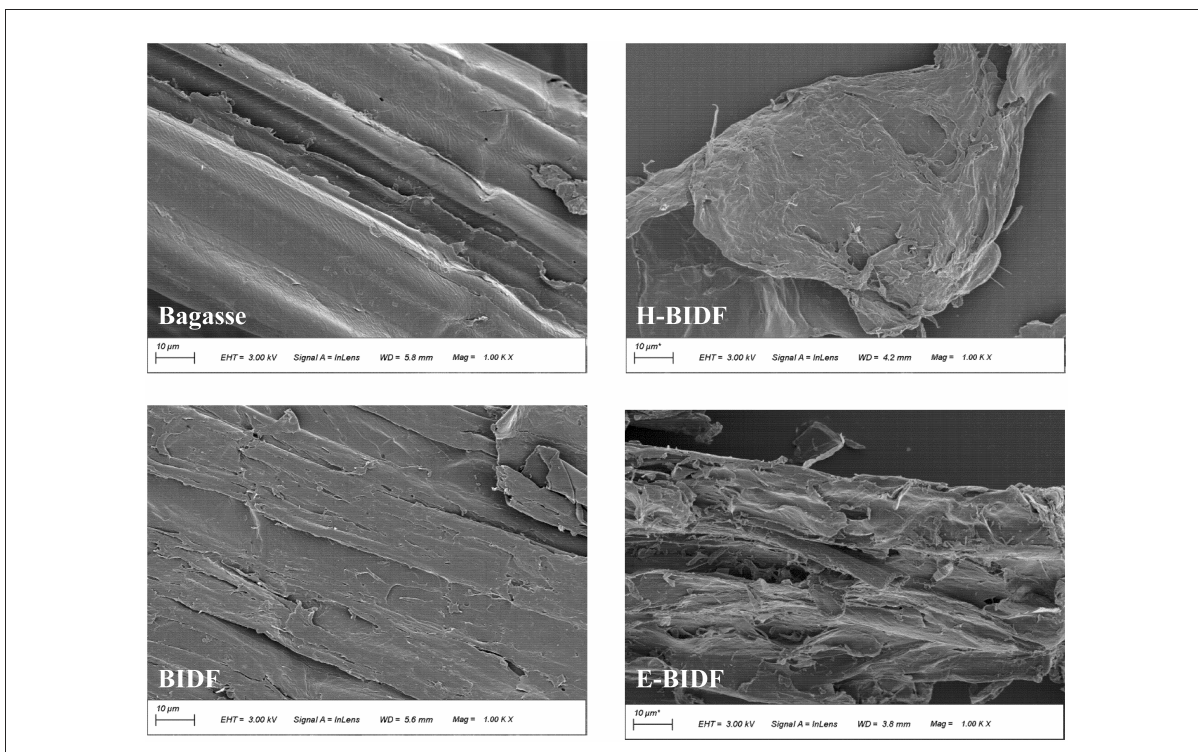
FIGURE3 The SEM images of bagasse, BIDF, H-BIDF and E-BIDF at × 1,000 magnification.